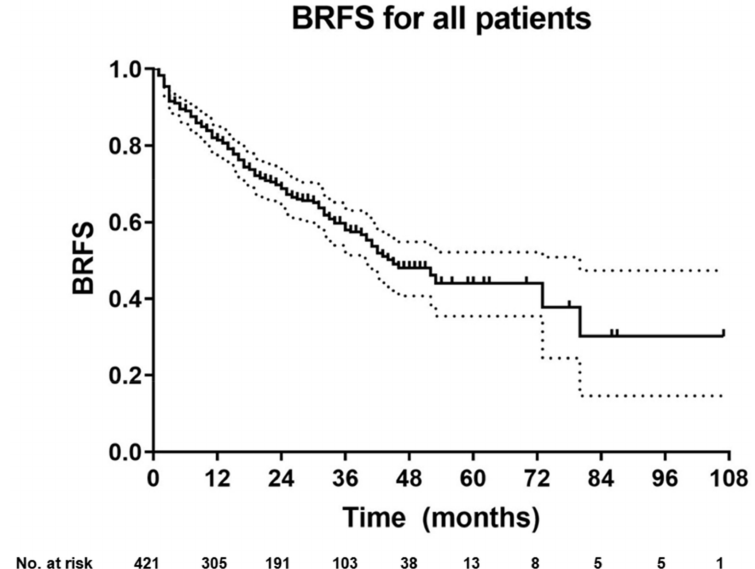
Figure 1. Kaplan–Meier curve of biochemical-recurrence free survival (BRFS) for the entire cohort. Plotted symbols represent censored points. Error bars show 95% confidence interval.